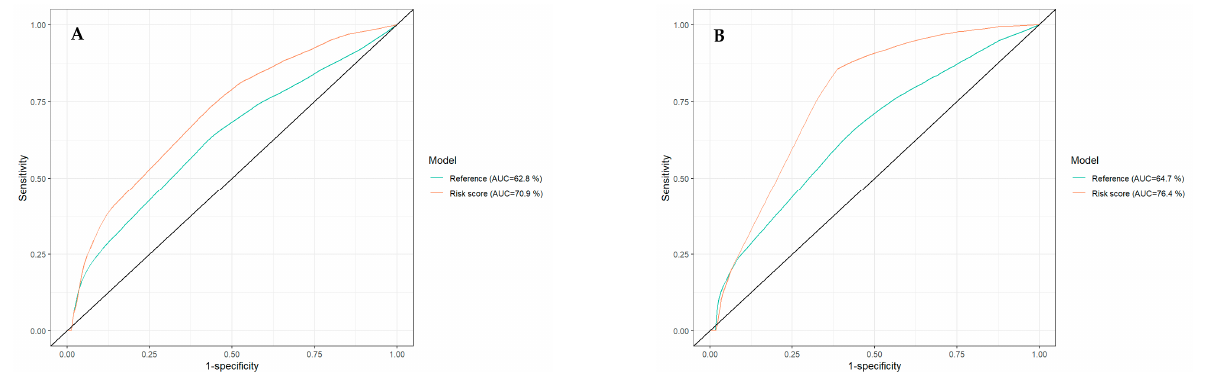
Figure 3. ROC (receiver operating characteristics) curves for the two prognostic models (reference vs. seven-marker signature model) with the endpoints MSS ( A ) and RFS ( B ). The plots illustrate varying prognostic abilities, i.e., sensitivity and specificity, for the seven-marker signature and conventional prognostic factors, such as tumor thickness, ulceration, and nodal status. As a measure of quality comparing the different models, area under the curve (AUC) can be calculated. A (endpoint MSS): with an AUC of 70.9% the model including the seven-marker signature shows superiority over the reference model (AUC = 62.8%). B (endpoint RFS): the model including the seven-marker signature showed a higher AUC (76.4% vs. 64.7%).